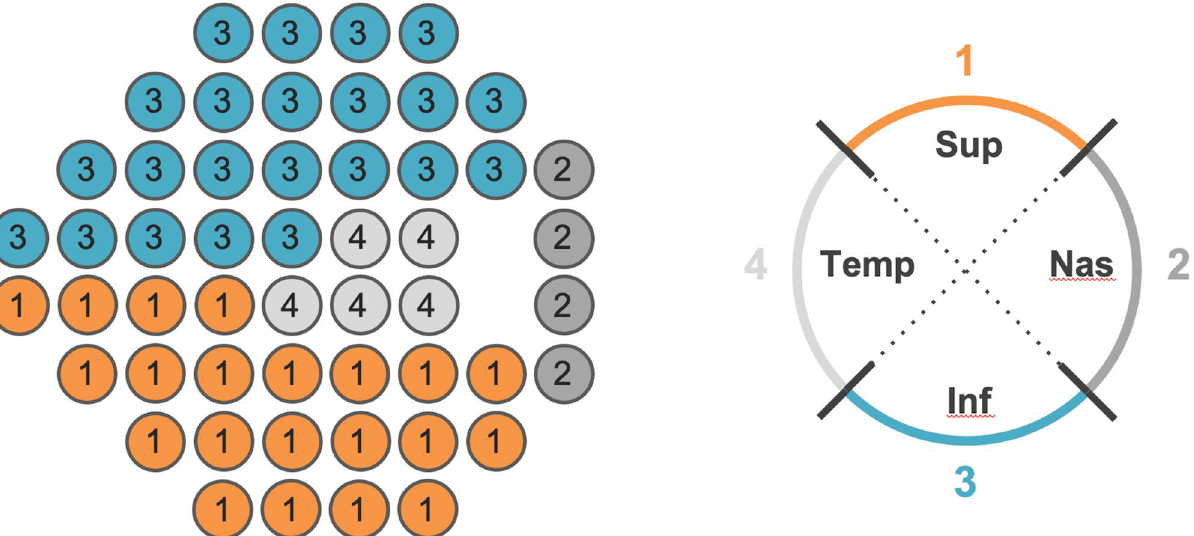
Figure 4. Topographic map relating the stimulus locations on a 24–2 visual field test (left) to regions where the retinal nerve fiber layer thickness was measured on optical coherence tomography (right) is shown for a right eye. Note : Sup, Superior; Nas, Nasal; Inf, Inferior; Temp,